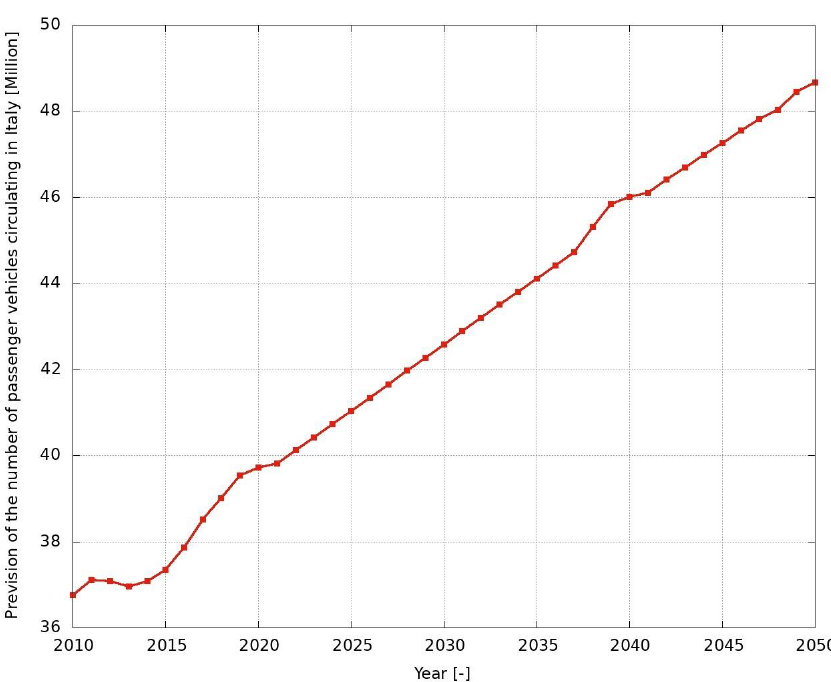
Figure 9. Prevision of the number of passenger vehicles circulating in Italy [17].